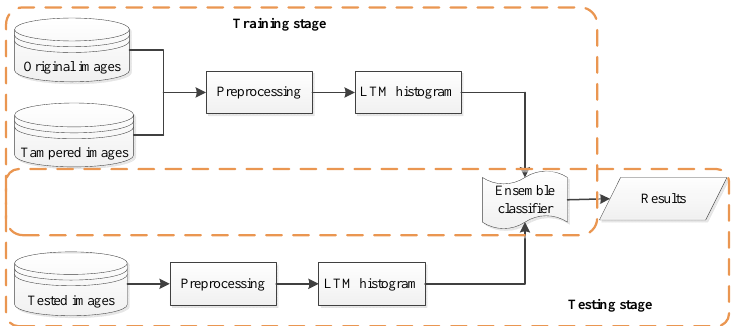
Figure 3. A block diagram of our proposed